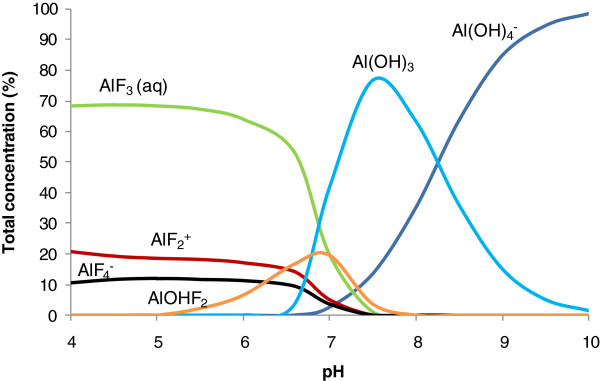
Calculated aluminium speciation as a function of pH in the presence of fluoride ([Al
T
] = 10.4 μM, [F
T
] = 379 μM, Table6).